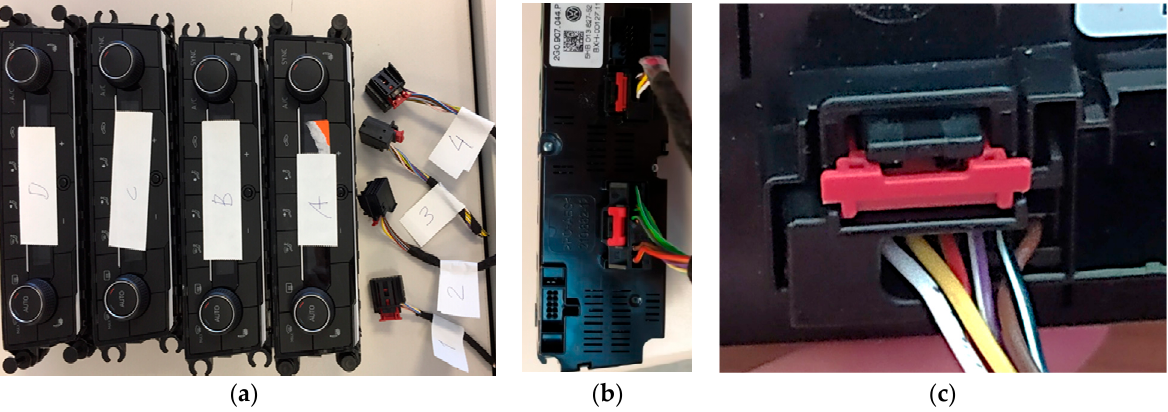
Figure 13. Climatronic: ( a ) devices and connectors, ( b ) back side, ( c ) connector.